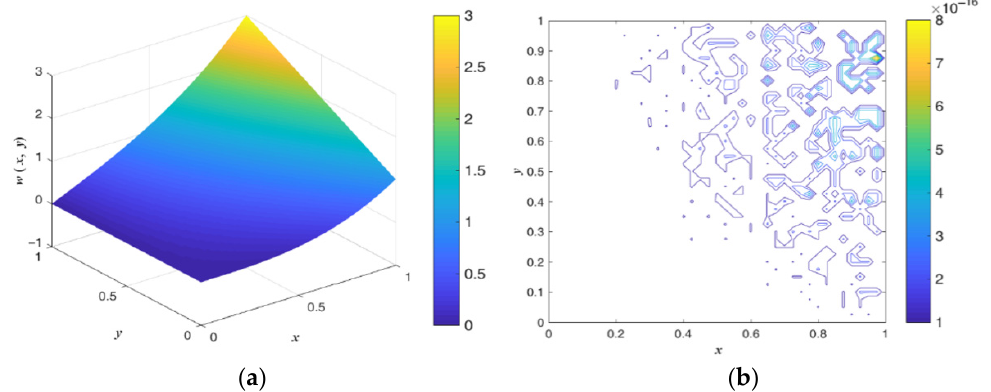
Figure 10. Potential distributions for a linear Poisson problem: ( a ) numerical solution; ( b ) absolute errors.